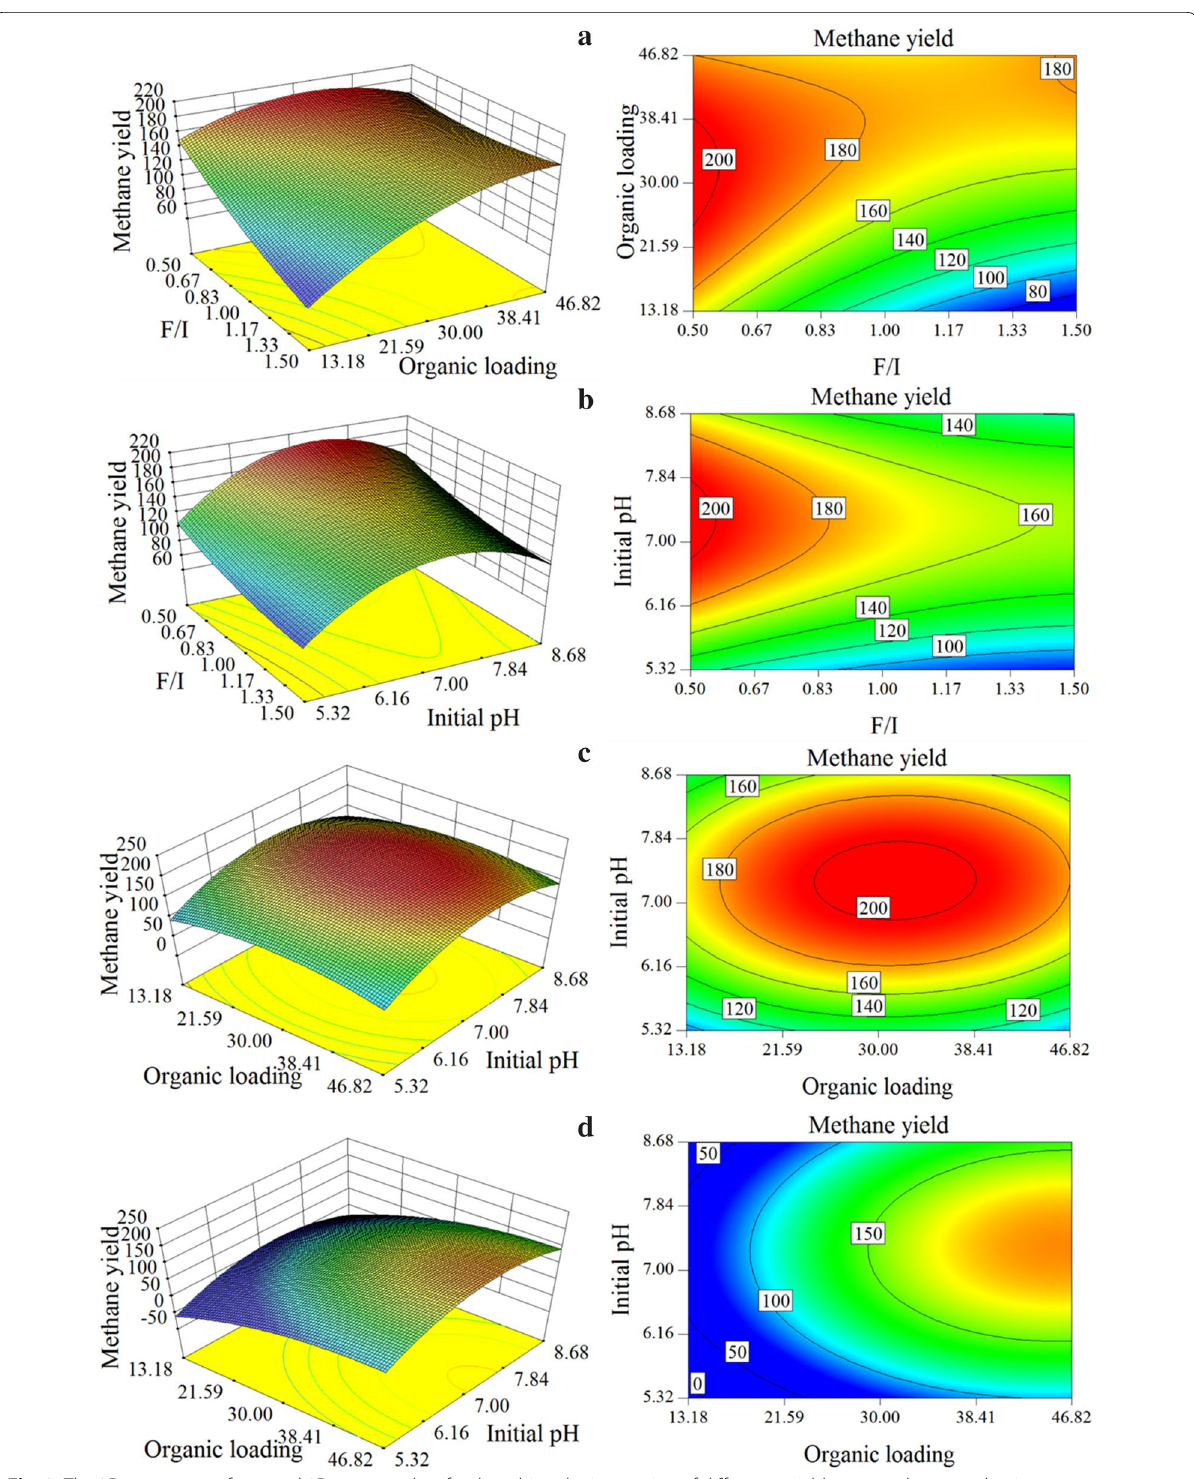
Fig. 2 The 3D response surfaces and 2D contour plots for describing the interaction of different variables on methane